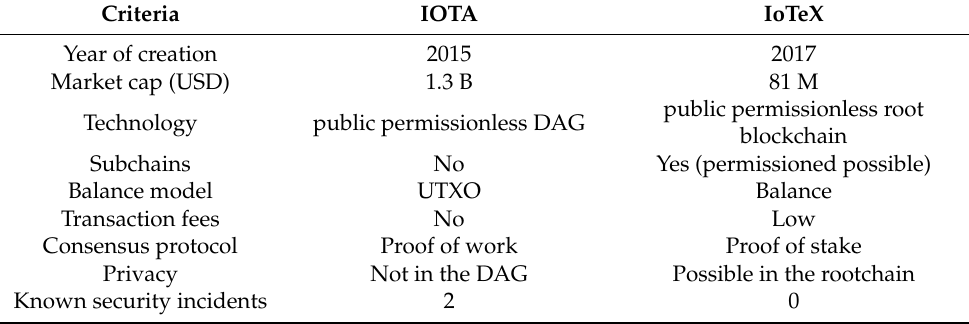
Table 6. IOTA vs IoTeX.